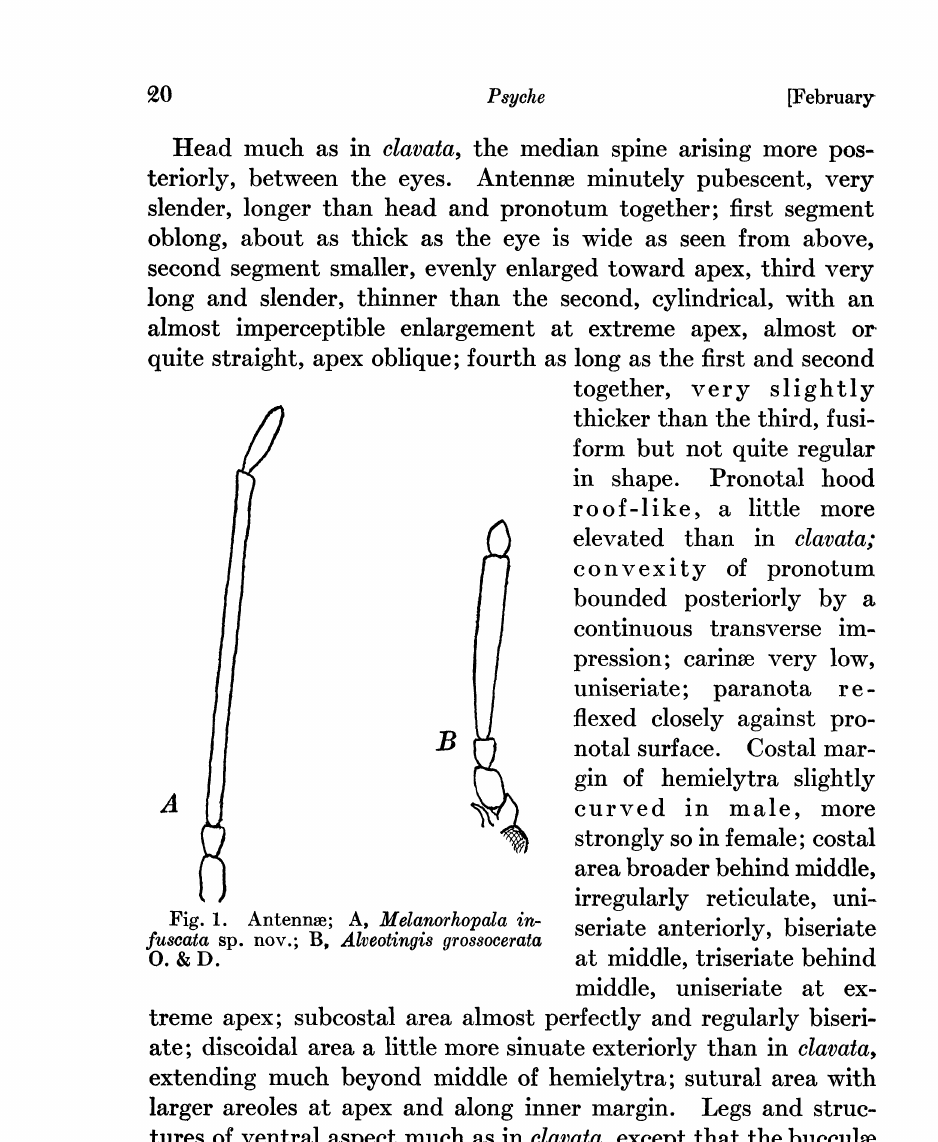
Fig. 1. Antennm; A, Melanorhopala in- fuscata sp. nov.; B, Alveotingis grossocerata